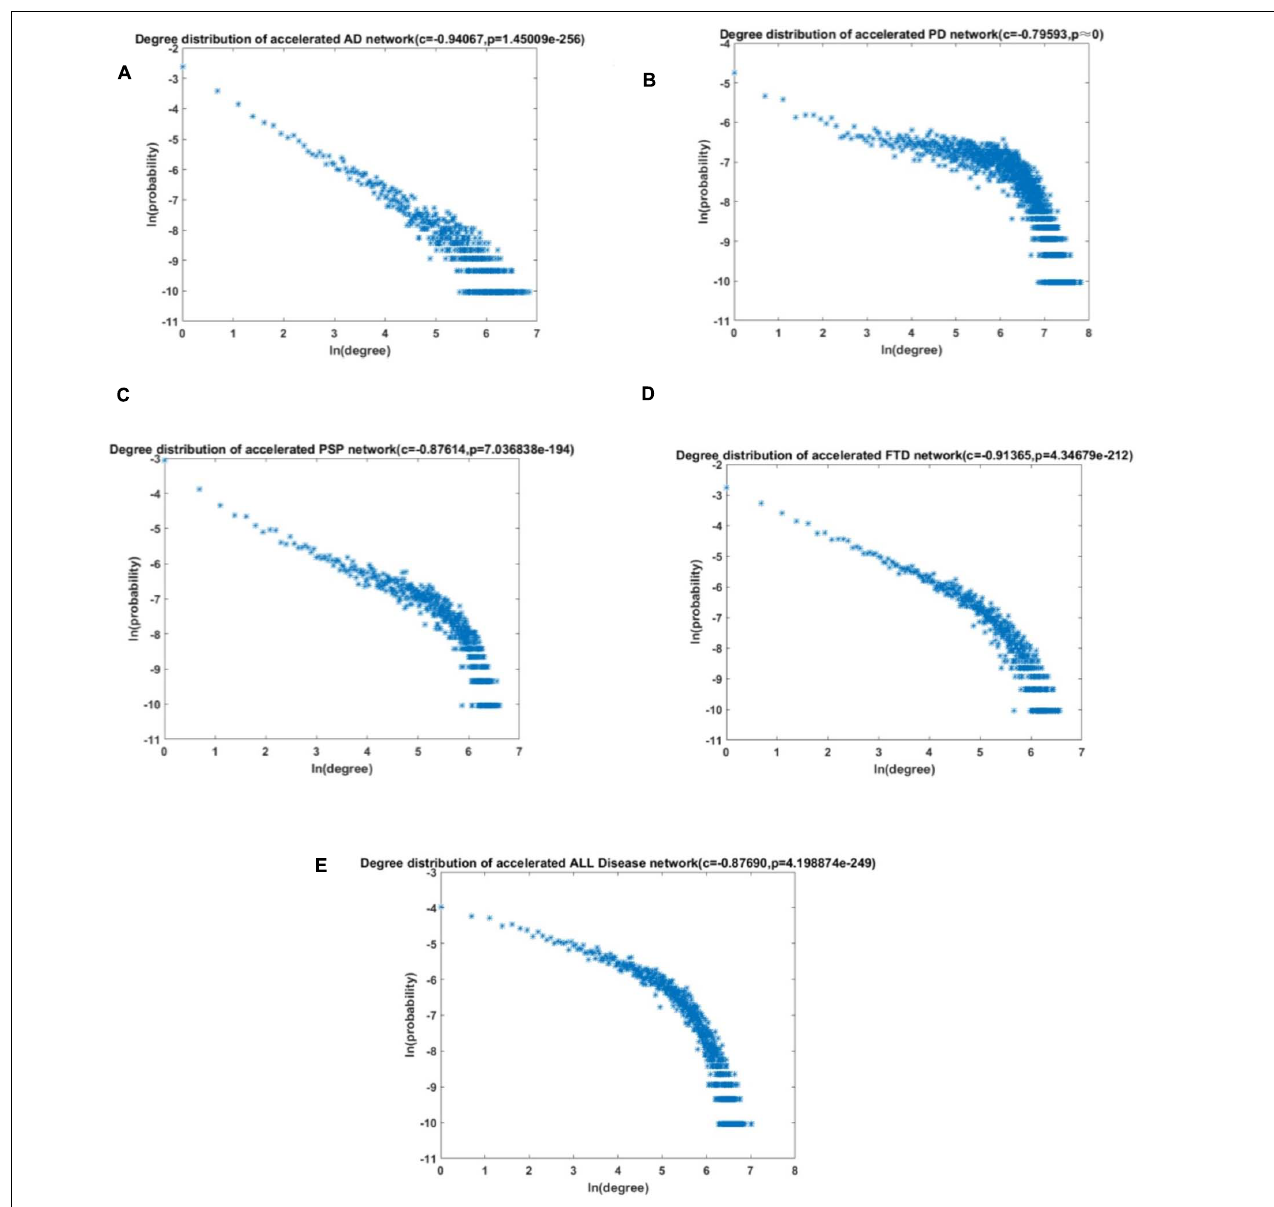
FIGURE 4 | The degree distribution of the acceleration aging network. (A) AD; (B) PD; (C) PSP; (D) FTD; and (E) All